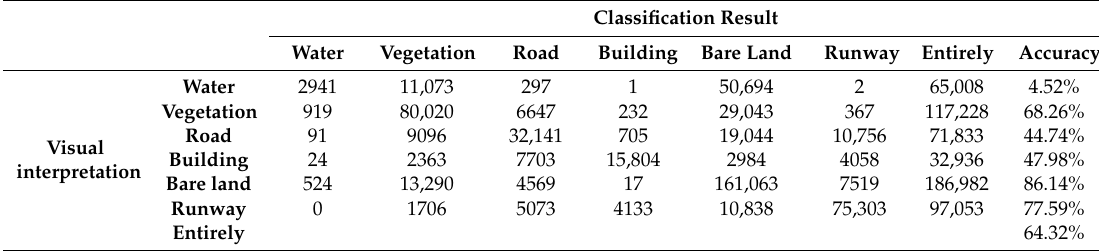
Table 5. Confusion matrix of true color image classification results in Pudong International Airport.